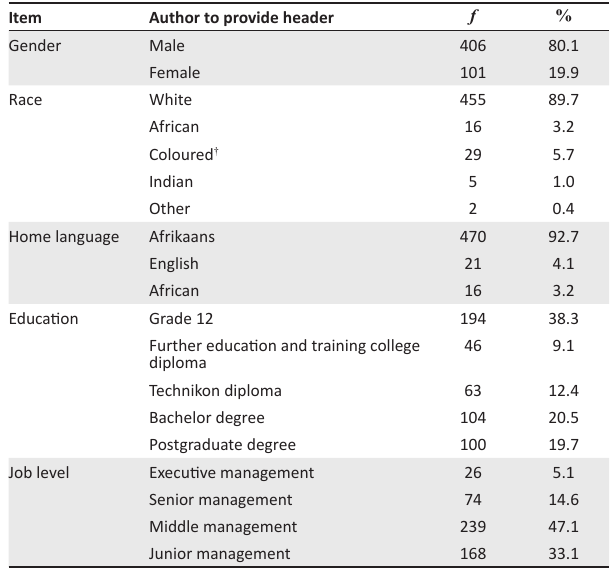
TABLE 1: Characteristics of the participants ( N =